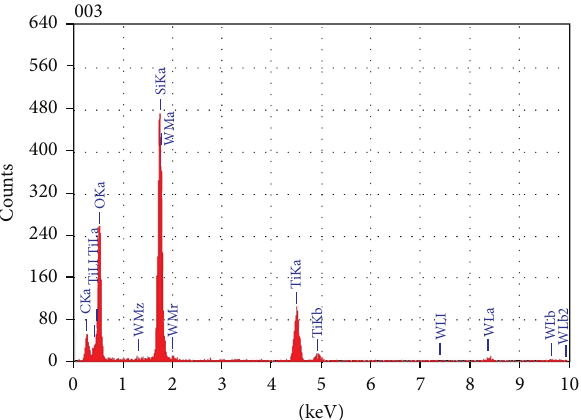
Figure 6: EDS spectrum of sample TAD measured from the interface layer. The strongest peaks belong to silicon and